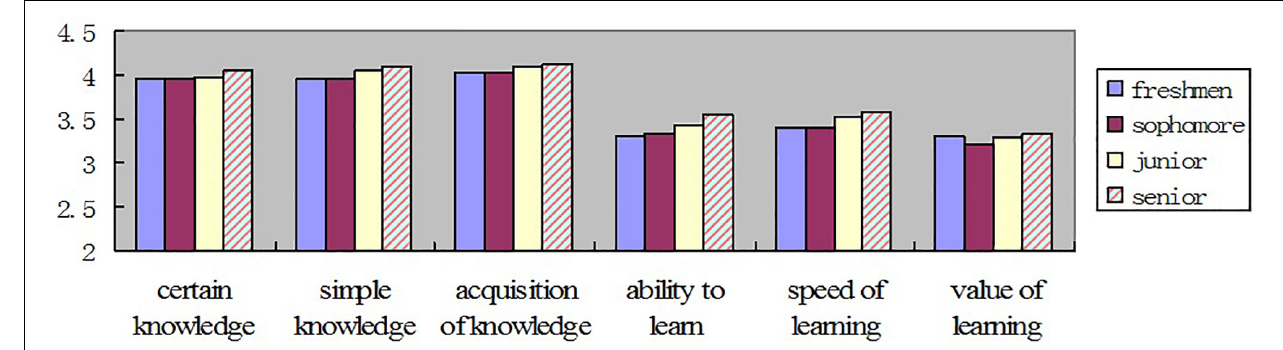
FIGURE 3 | The development of the dimensions on college students’ epistemological beliefs among different grades.